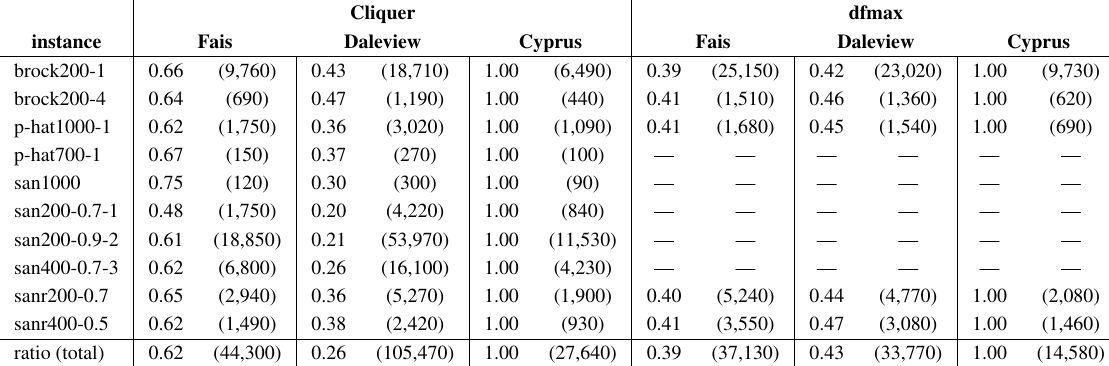
Table 9. Calibration experiments for Cliquer and dfmax using 3 machines. Cliquer